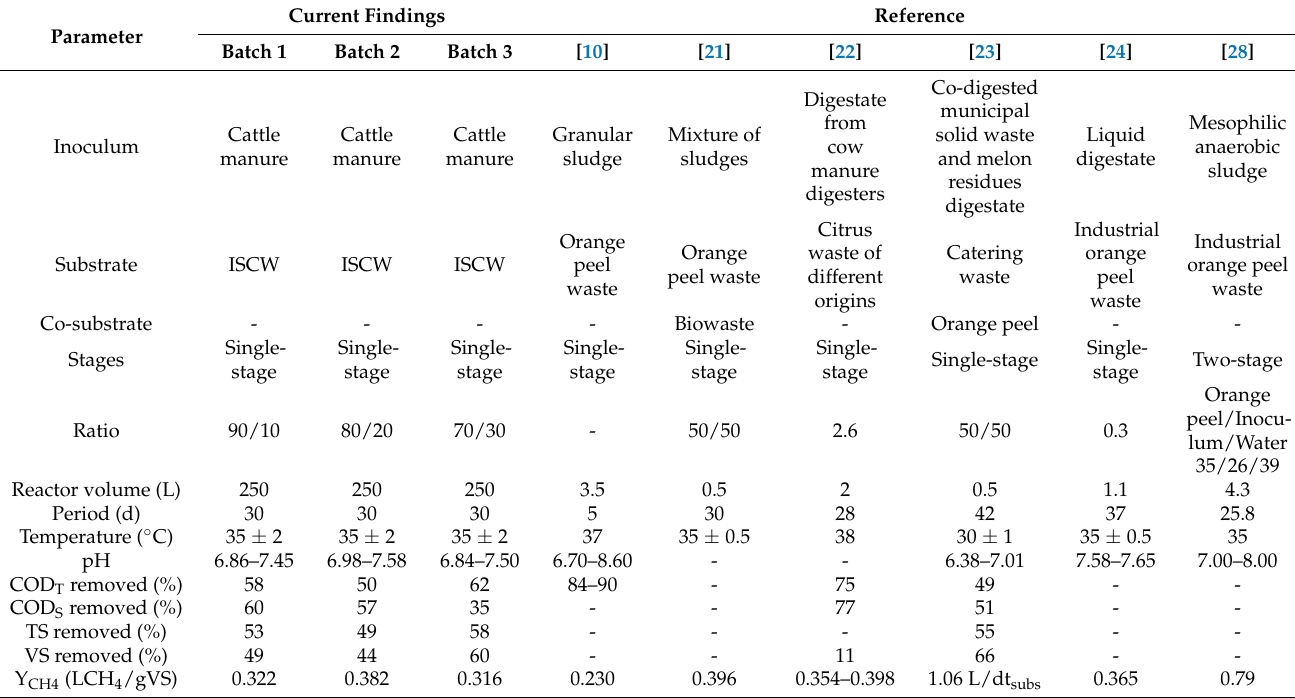
Table 3. Summary of the current findings with other common